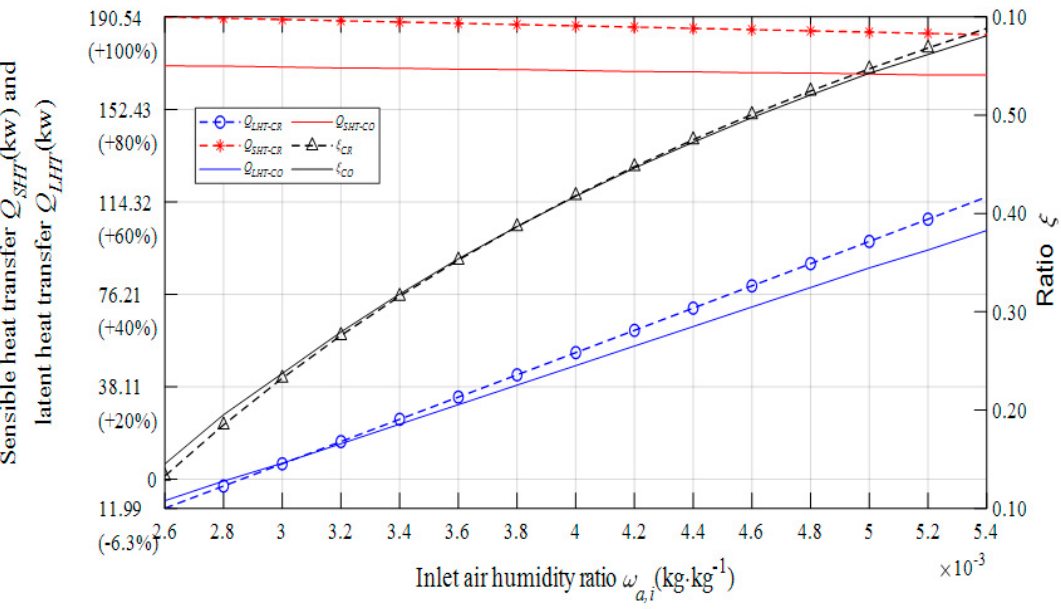
Figure 13. Influence of inlet air humidity ratio on energy transfer characteristics.